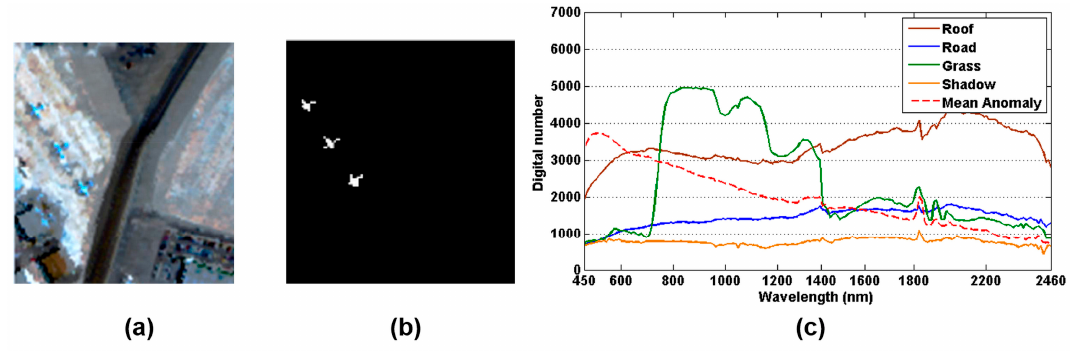
Figure 3. ( a ) The image scene of PaviaC dataset by the ROSIS sensor; ( b ) ground truth map of 47 pixels representing anomalies; and ( c ) spectral curves of background and average anomalous signature. Figure 4. ( a ) The image scene of San Diego dataset by the AVIRIS sensor; ( b ) ground truth map of 58 pixels representing anomalies; and ( c ) spectral curves of background and average anomalous signature.